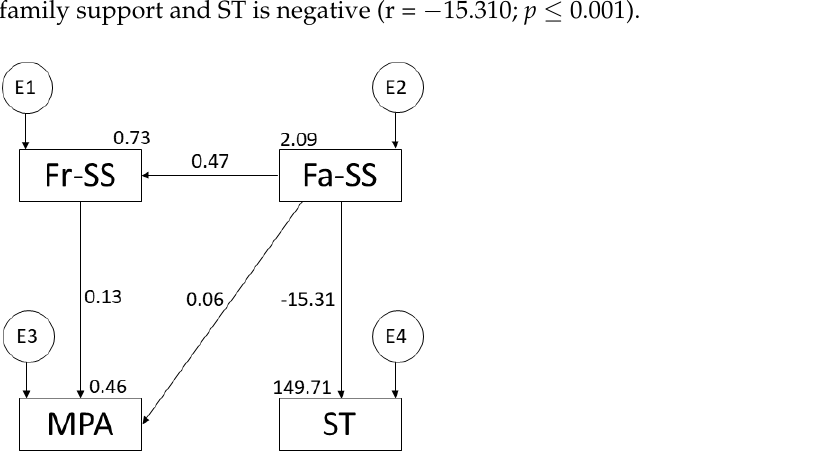
Figure 3. Model suggested for adolescent moderate-PA. Note: family support (Fa-SS); friend support (Fr-SS); moderate physical activity (MPA); screen time (ST).